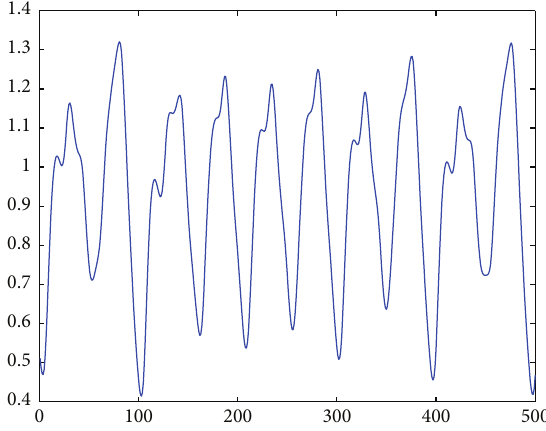
Figure 2: Mackey-Glass chaotic time